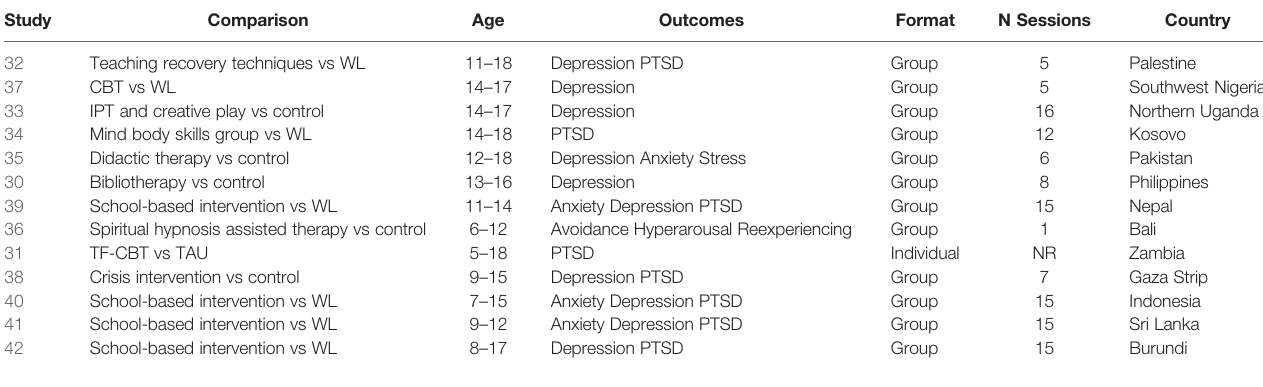
TABLE 5 | Characteristics of included